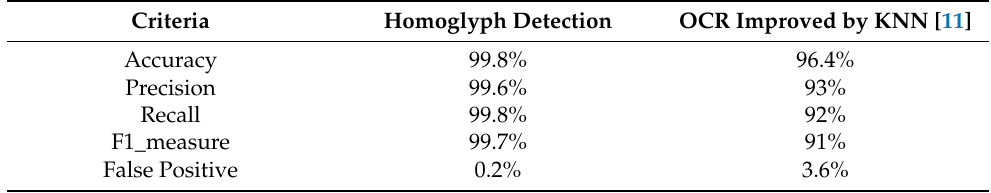
Table 5. Homoglyph detection accuracy.